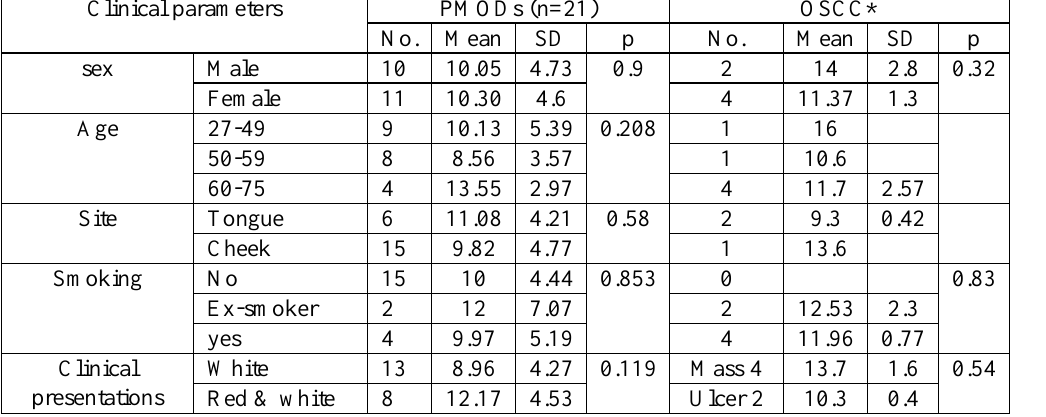
Table (3): Mean value and standard deviation of MVD in relation to clinical parameters. Clinical parameters